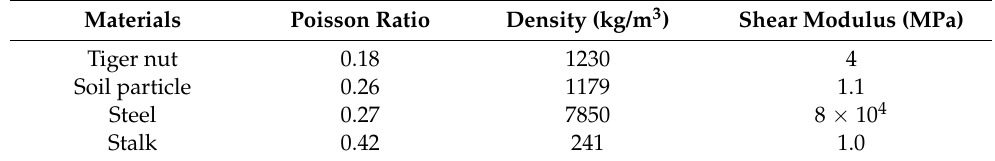
Table 5. Parameters of mechanical parameters.